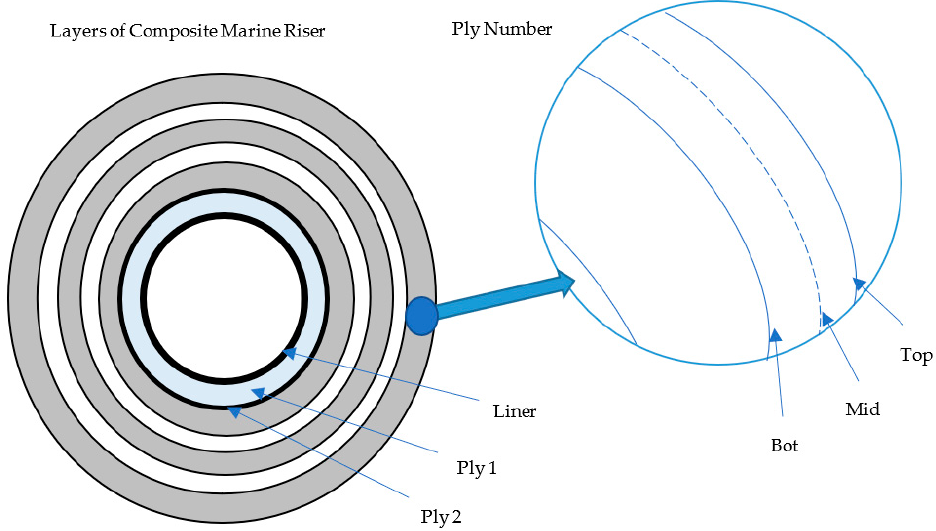
Figure 7. Layers of composite riser depicting locations of top, mid, and bottom for stress plots.